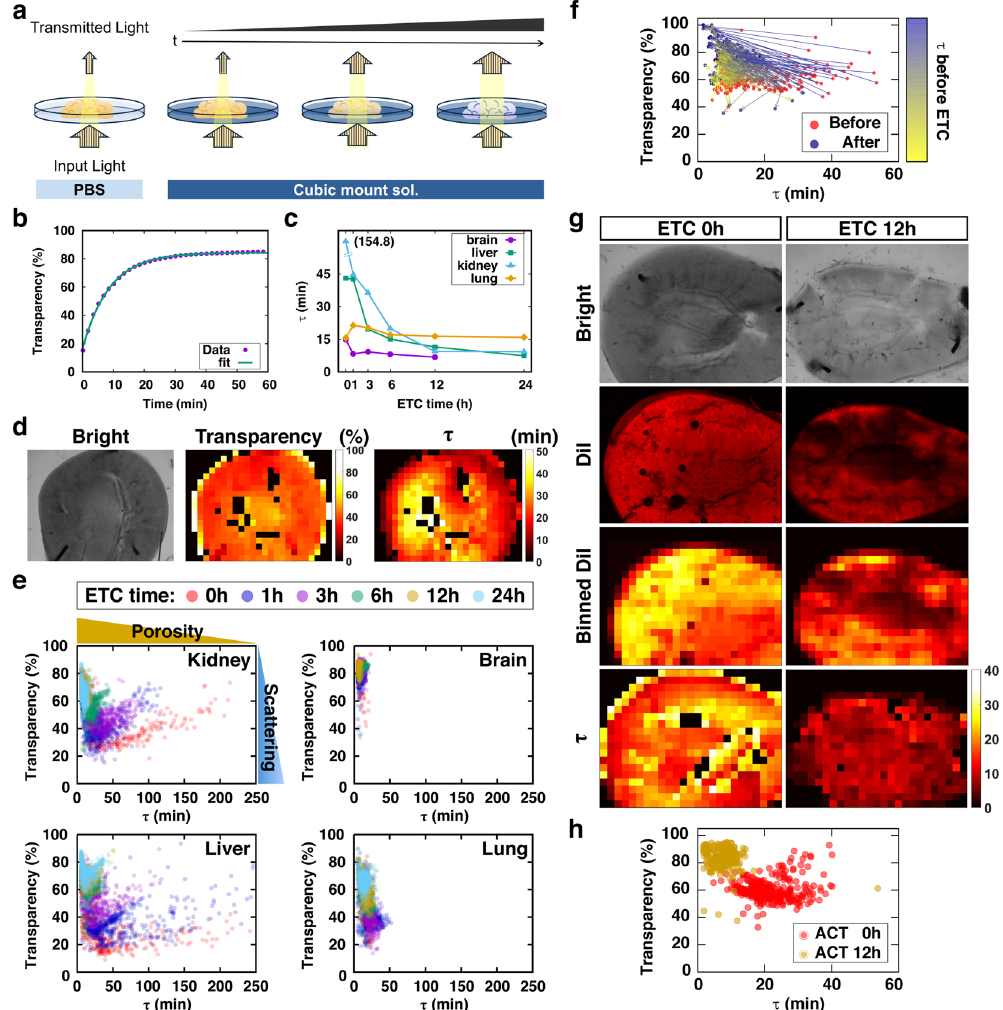
Figure 4. Molecular diffusion-based evaluation method for tissue clearing (a) Conceptual image showing the evaluation process of tissue clearing with two variables: transparency and time constant ( τ ) for the diffusion of RI-matching solution. (b) Time-transparency data fitted to one-phase association function to get time constant and final transparency. (c) τ profile of each organ at different ETC time points. (d) Sample images of the same mouse kidney slice: bright-field image (left), transparency map (middle), τ map (right). (e) τ -transparency scatter plot, which could indicate the optical properties of a cleared tissue. Each data points were obtained from 3 independent samples in each organ at each ETC time point. (f) τ and transparency relations for each points of a kidney sample before (red dots) and after 12 hr ETC (blue dots) and their position change (colored arrows). The colors of arrow were from τ values before ETC. (g) Images of mouse kidney at ETC 0 and 12 hr. (h) Scatter plot of τ -transparency from samples in (g)